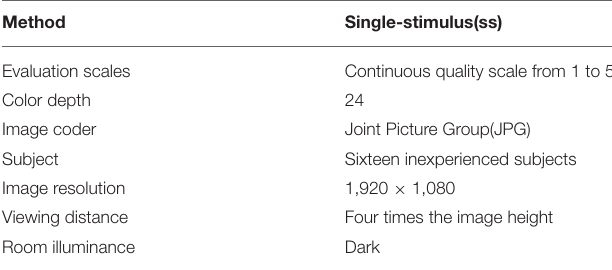
TABLE 1 | Subjective experimental conditions and